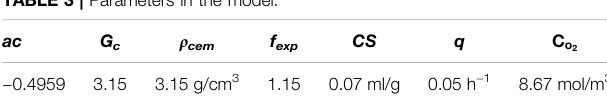
TABLE 3 | Parameters in the model.